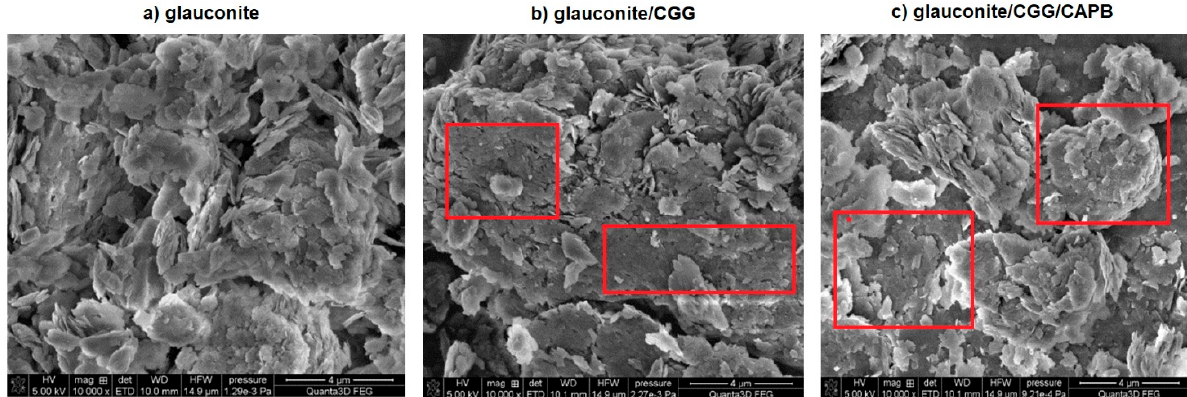
Figure 10. SEM image of glauconite: ( a ) pure glauconite, ( b ) glauconite/CGG, ( c ) glauconite/CGG/CAPB; magnification: ×10,000.